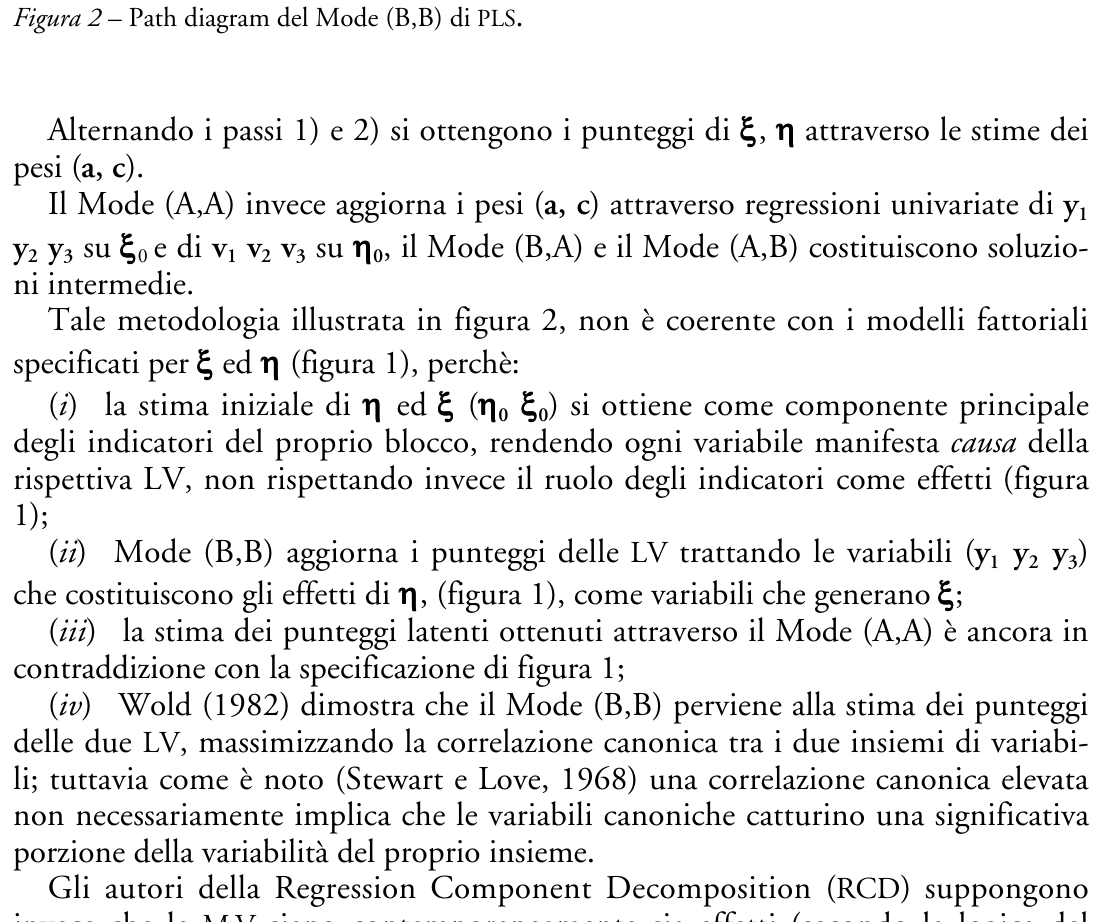
Figura 2 – Path diagram del Mode (B,B) di PLS